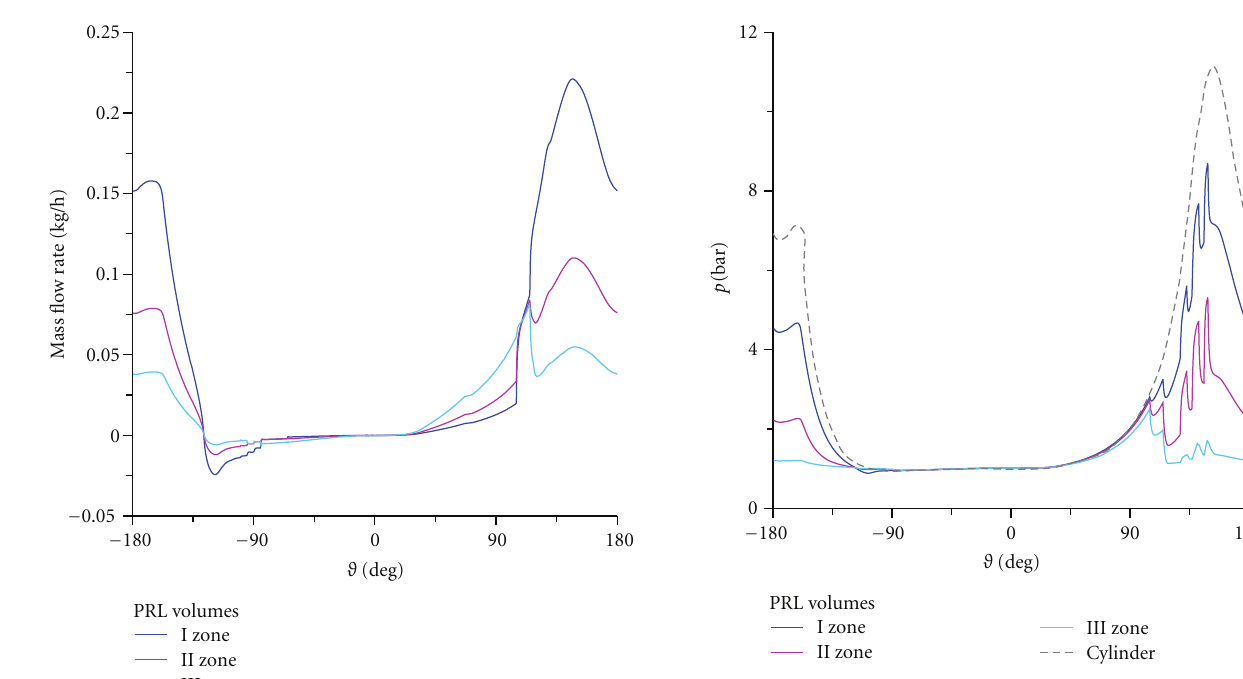
Figure 18: Pressure in PRL volumes, β = 8, flutter